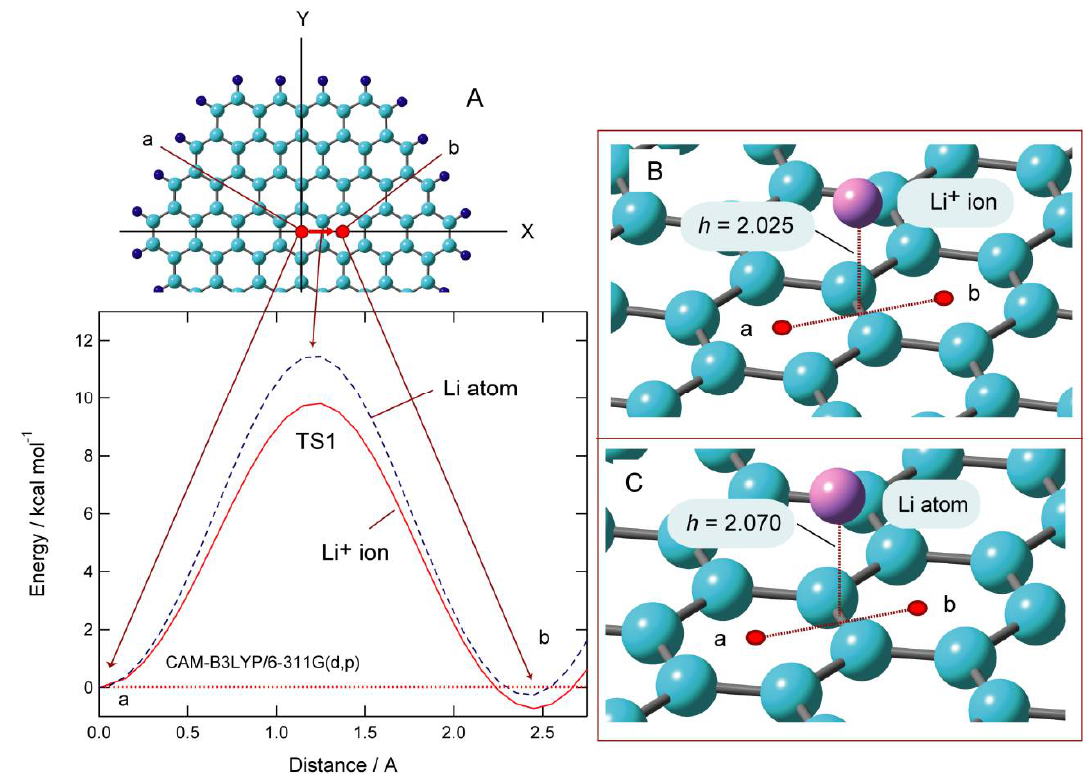
Figure 8. ( A ) The potential energy curves for the diffusion of the Li + ion and Li atom along the points a → b path on the surface. The heights of the Li + ion and Li atom were set to 1.777 and 1.729 Å, respectively. Optimized transition state structures for the diffusion of the ( B ) Li + ion and (C) Li atom on GNF(37). The height ( h ) of Li is given in Å. All calculations were carried out at the CAM-B3LYP/6-311G(d,p) level of theory. Reprinted with permission from [41]. Copyright 2020 Elsevier.